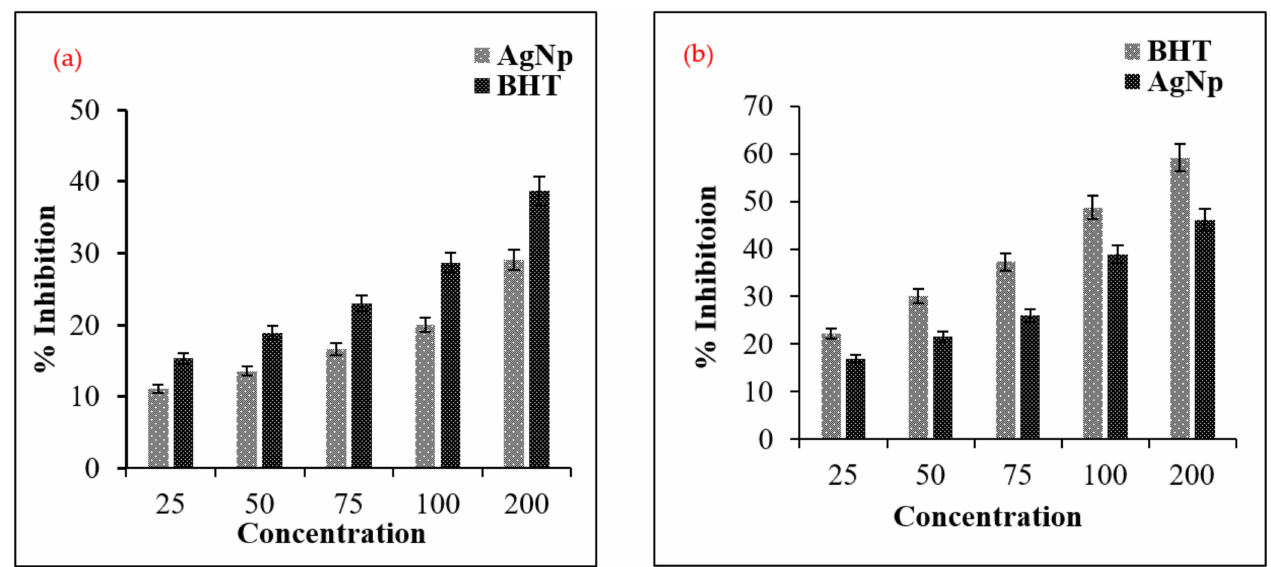
Figure 9. The activities of antioxidants using ( a ) DPPH ( b ) PFRAP assay.